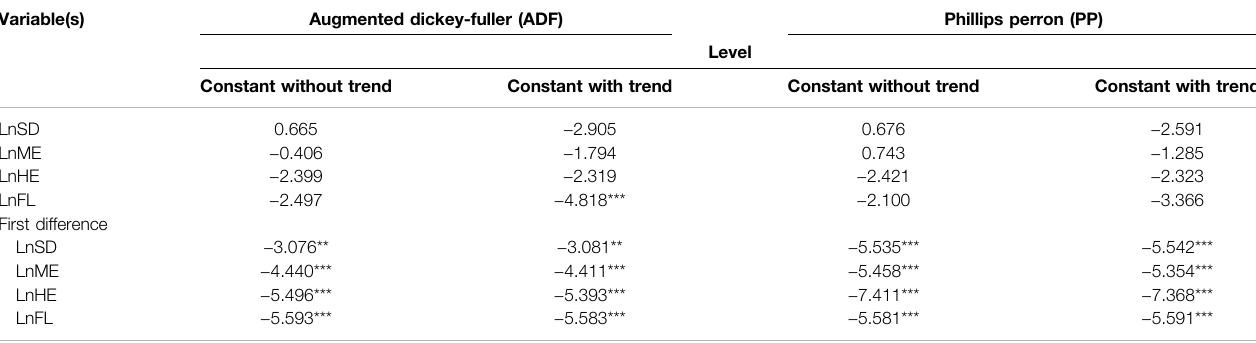
TABLE 2 | Unit root tests (without structural breaks).